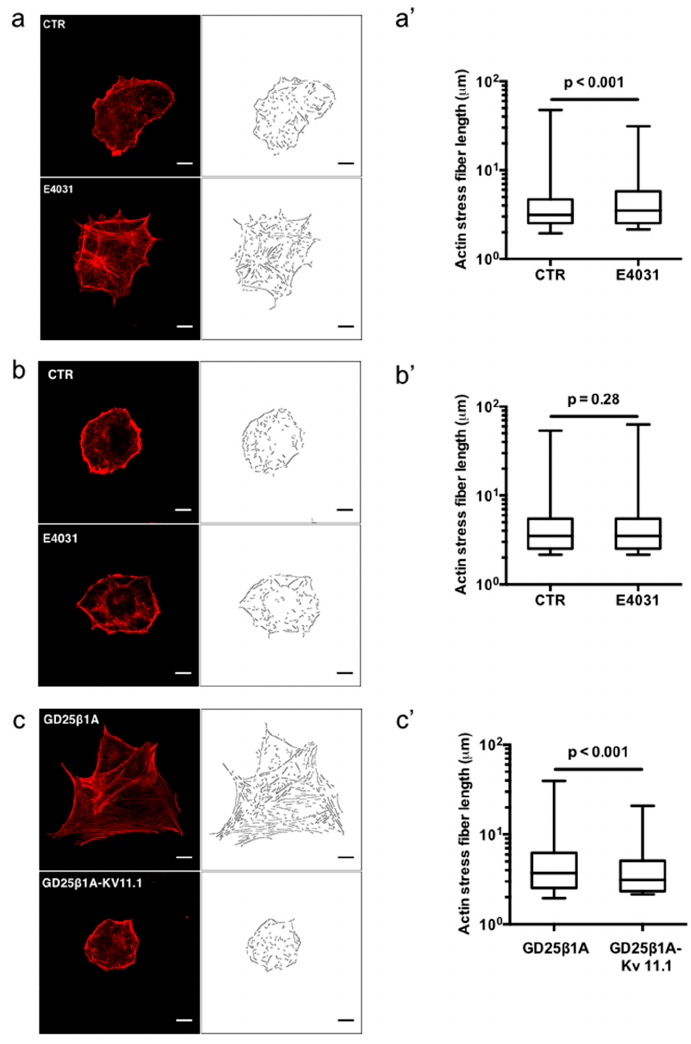
Figure 2. Actin stress fiber formation in PANC-1, BxPC3, and GD25 cells cultured onto FN. ( a ) Representative confocal images of fixed PANC-1 cells in the absence (control (CTR)) and presence of 40 µ M E4031 (E4031). Actin staining by rhodamine-conjugated phalloidin (red). The right panels show the detected and segmented stress fibers from the actin signal (see Materials and Methods section for details). Scale bars: 10 µ m. ( a’ ) Distribution of actin stress fibers in PANC-1 cells in CTR and E4031 conditions. Boxes include central 50% of data points, the horizontal lines denote minimum value, median and maximum value. At least a total of 40 cells per condition from three independent experiments were analyzed. All p -values were determined by a Mann–Whitney test (significant level set to p < 0.05), or for data deviating from normality by a Kolmogorov–Smirnov test. ( b ) Representative confocal images of fixed BxPC3 cells in the absence (CTR) and presence of 40 µ M E4031 (E4031). Actin staining by Rhodamine-conjugated phalloidin (red). The right panels show the detected and segmented stress fibers from the actin signal (see Materials and Methods section for details). Scale bars: 10 µ m. ( b’ ) Distribution of actin stress fibers in BxPC3 cells in CTR and E4031 conditions. Boxes include central 50% of data points, the horizontal lines denote minimum value, median and maximum value. At least a total of 40 cells per condition from three independent experiments were analyzed. All p -values were determined by a Mann–Whitney test (significant level set to p < 0.05), or for data deviating from normality by a Kolmogorov–Smirnov test. ( c ) Representative single cell image of GD25 β 1A and GD25 β 1A-K V 11.1 cells. Actin staining by rhodamine-conjugated phalloidin (red). The right panels show the detected and segmented stress fibers from the actin signal (see Materials and Methods section for details). Scale bars: 10 µ m. ( c’ ) Distribution of actin stress fibers in GD25 β 1A and GD25 β 1A-K V 11.1 cells. Boxes include central 50% of data points, the horizontal lines denote minimum value, median and maximum value. At least a total of 40 cells per condition from three independent experiments were analyzed. All p -values were determined by a Mann–Whitney test (significant level set to p < 0.05), or for data deviating from normality by a Kolmogorov–Smirnov